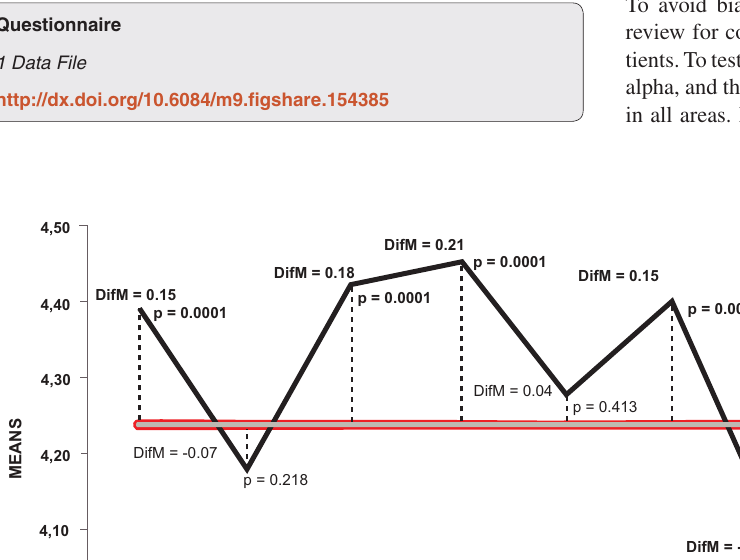
p = 0.04), nurse care ( m = 4.15; p = 0.048), HCAs ( m = 4.04; p = 0.046) and diagnostic tests ( m = 3.63; p =